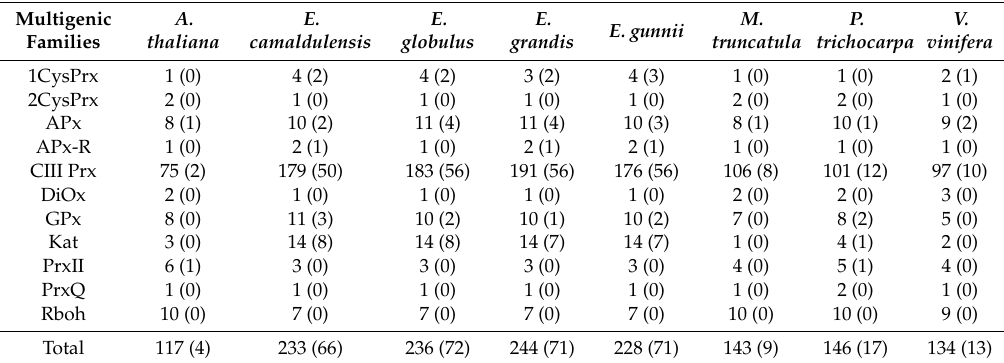
Table 3. Isoform numbers found in 8